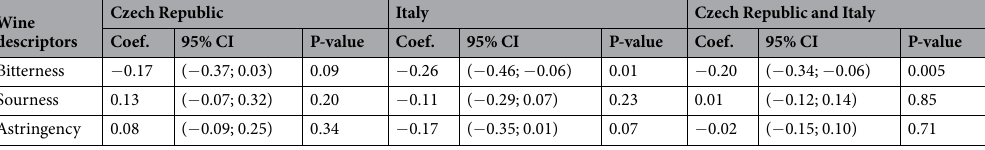
Table 1. Associations between PROP sensitivity and wine